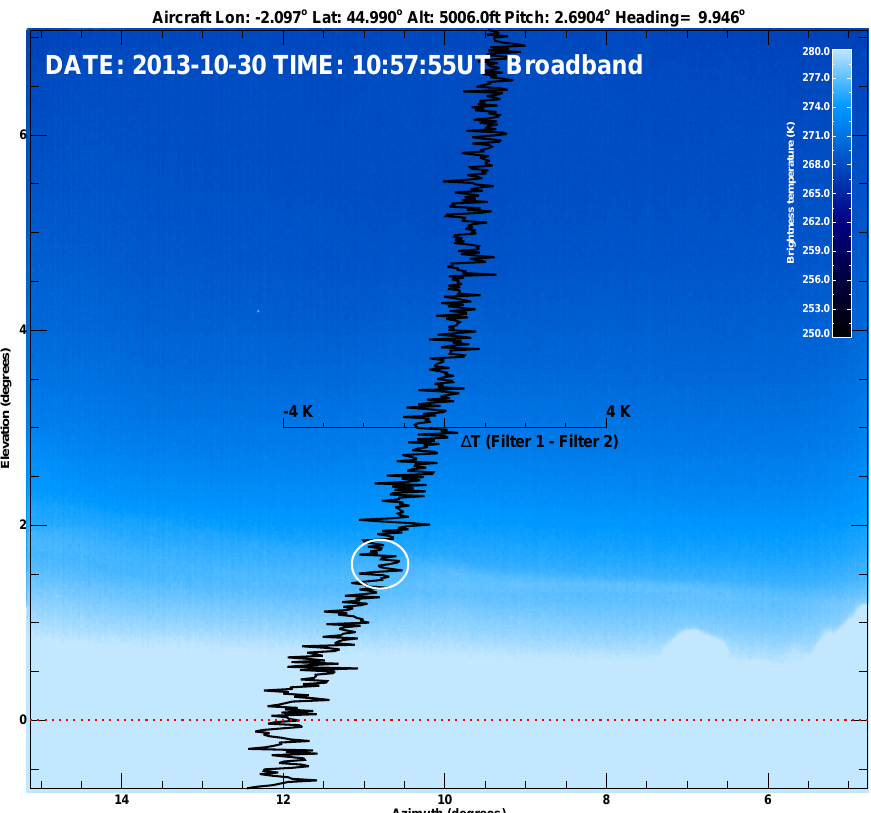
Figure 14. Broadband temperature image acquired by the instrument when the aircraft altitude was 5000 ft and the instrument was viewing upwards and ahead of the aircraft. The solid black line is a vertical temperature difference transect (Broadband-10.8 µ m filter) through the ash layer. The horizontal scale for the transect is in Kelvin and the noise level is 1 K. ∼± The white circle shows the location of the position of the ash layer at the transect location. The ash layer can be discerned in the broadband image through spatial pattern recognition but cannot be discriminated from the meteorological clouds lower down.